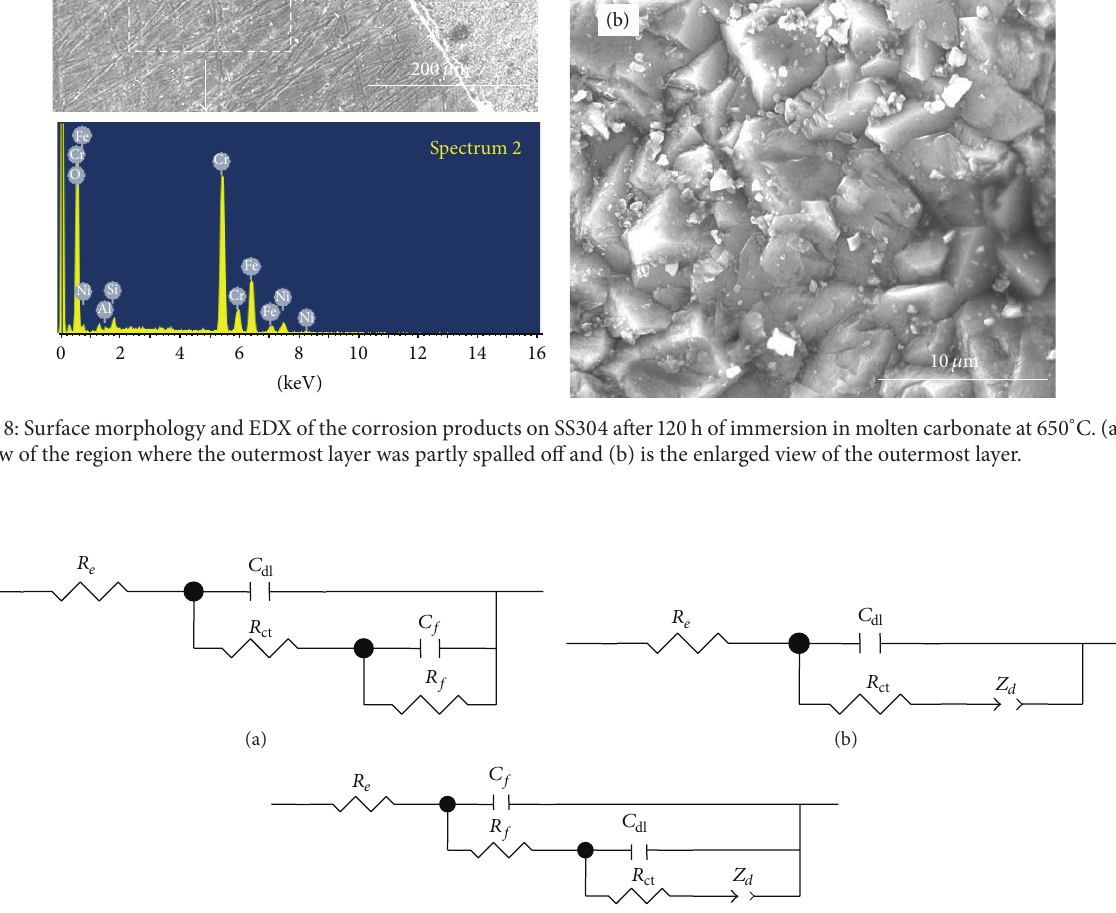
or Fe 3 O 4 were able to precipitate where the oxygen pressure was low enough beneath the thick LiFeO 2 layer, but they are confined to a 2 𝜇 m region on the bulk-metal